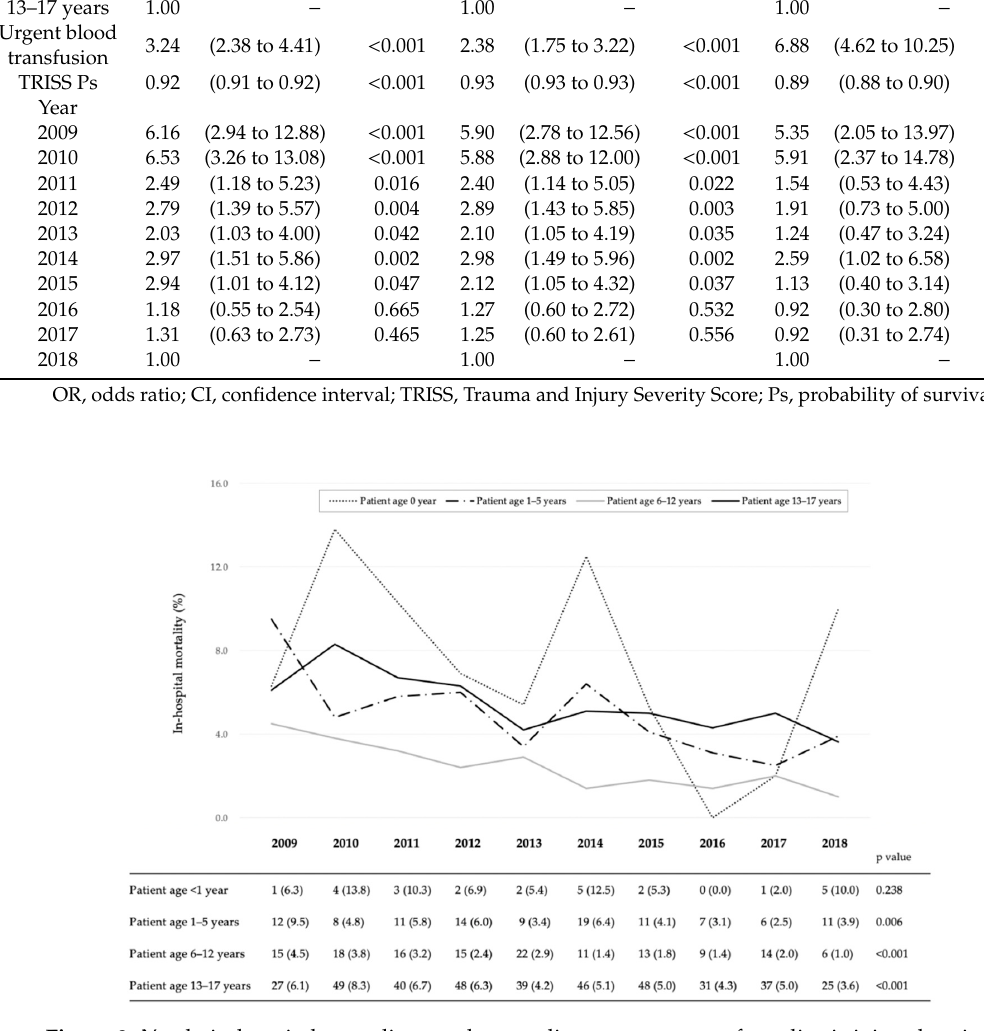
Figure 2. In-hospital mortality trends for paediatric injured patients by year. ISS, Injury Severity Score; TRISS, Trauma and Injury Severity Score; Ps, probability of survival.